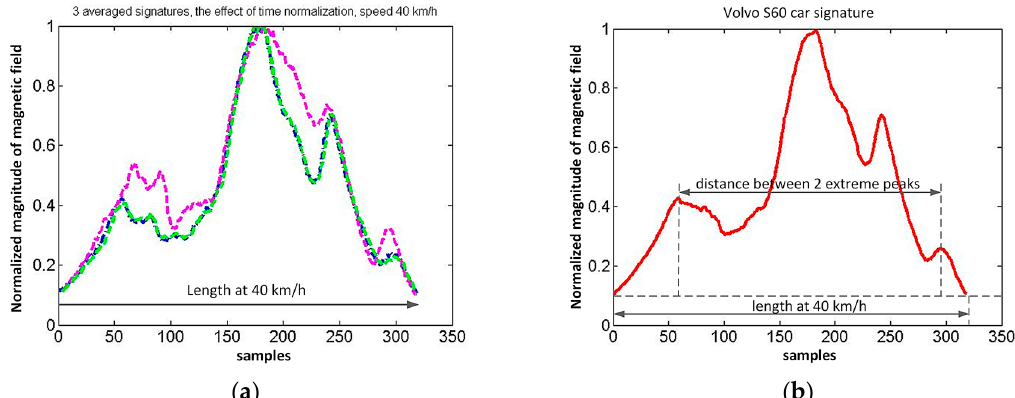
Figure 10. The effect of amplitude normalization and the estimation of three waveform lengths in samples.